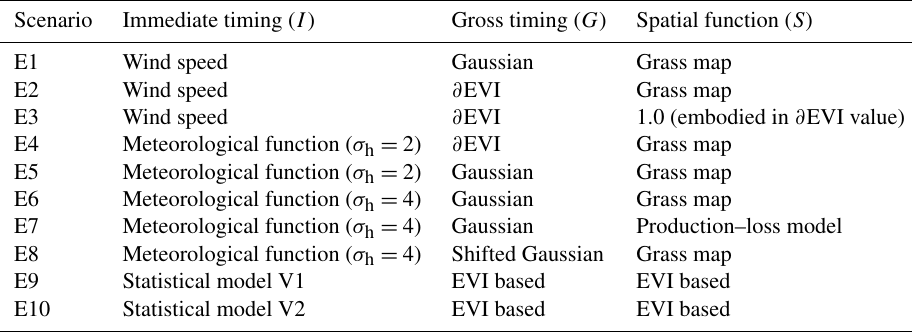
Table 2. Options tested for pollen emission in this study. EVI denotes the enhanced vegetation index. Scenario Immediate timing ( I ) Gross timing ( G ) Spatial function ( S ) E1 Wind speed Gaussian Grass map E2 Wind speed ∂ EVI Grass map E3 Wind speed ∂ EVI 1.0 (embodied in ∂ EVI value) E4 Meteorological function ( σ h = 2) ∂ EVI Grass map E5 Meteorological function ( σ h = 2) Gaussian Grass map E6 Meteorological function ( σ h = 4) Gaussian Grass map E7 Meteorological function ( σ h = 4) Gaussian Production–loss model E8 Meteorological function ( σ h = 4) Shifted Gaussian Grass map E9 Statistical model V1 EVI based EVI based E10 Statistical model V2 EVI based EVI